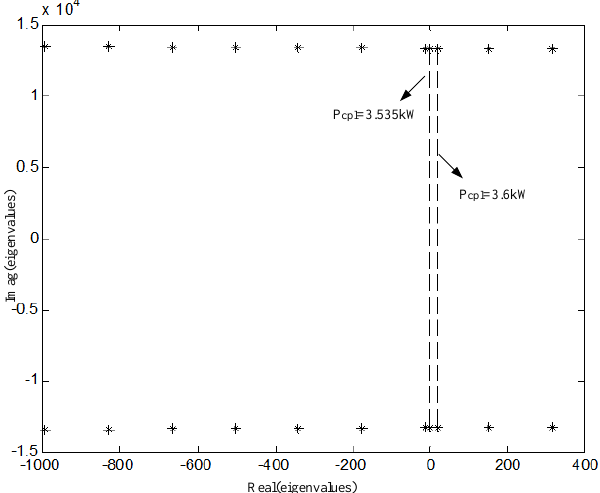
Figure 5. Eigenvalue plot of system.